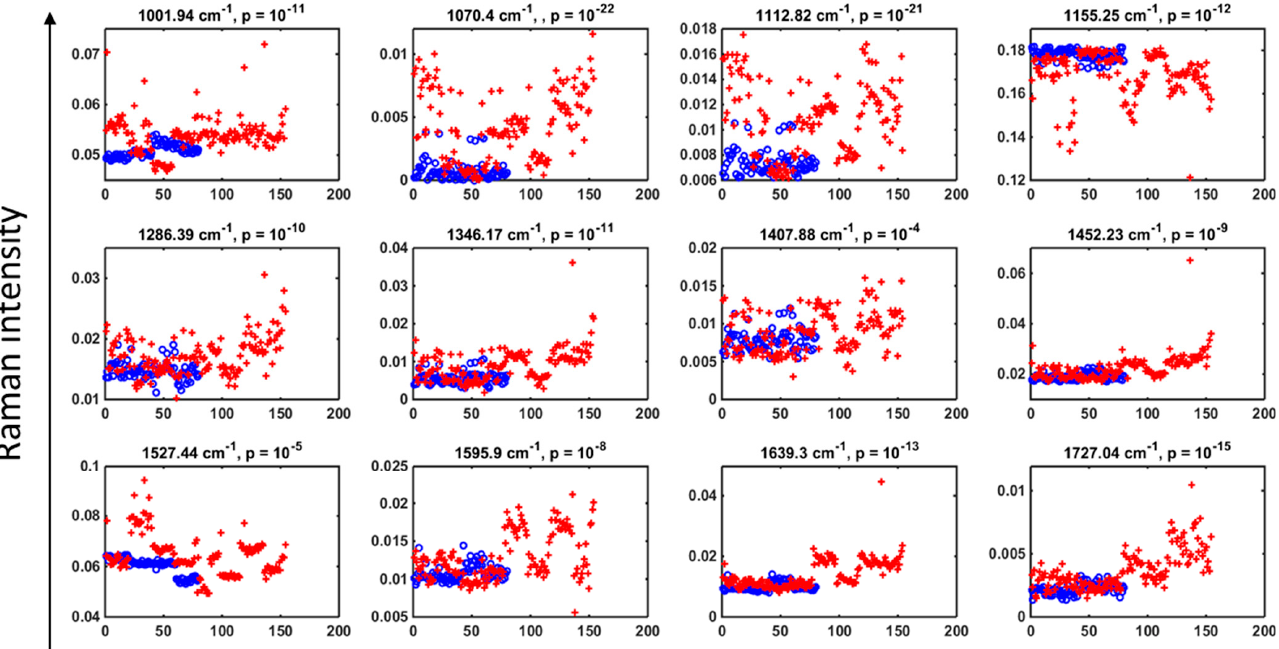
Figure 2. PCA-LDA discriminant scores for SLE-associated biomarkers. Raman intensity for each biomarker peak along with their p -value: healthy controls (o) and SLE patients (+). All peaks were found to be highly statistically significant at p < 0.001. p -value calculated based on an ANOVA test.